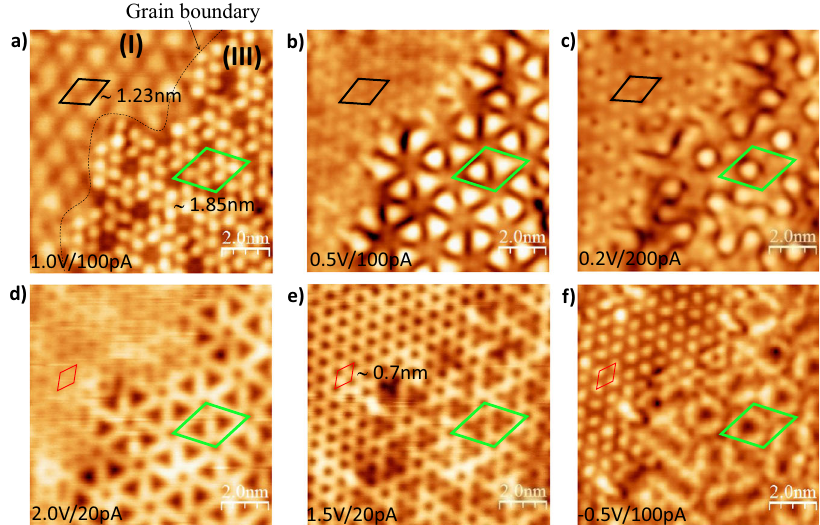
Fig. 2 STM images of the same 10 × 10 nm 2 scan area taken at the interface between (I) and (III) shown in Fig. 1 c with different imaging conditions. a 1 V/100 pA, b 0.5 V/100 pA, c 0.2 V/200 pA, d 2.0 V/20 pA, e 1.5 V/20 pA, f − 0.5 V/100 pA. The twist angles ( θ ) between the graphene and the MoTe 2 lattices are 30 ∘ and 34.3 ∘ in the region ( I ) and ( III ). Supercells are marked by black and green hexagons in the two ffiffiffi p ffiffiffi p 3 7 regions named as 2 R30 ∘ and 2 R19.1 ∘ in Wood's notation,